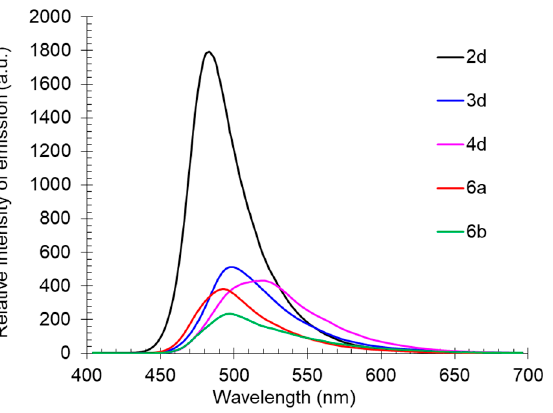
Figure 12. Solid-state photoluminescence spectra of compounds 2d, 3d, 4d, 6a, and 6b in a pow-